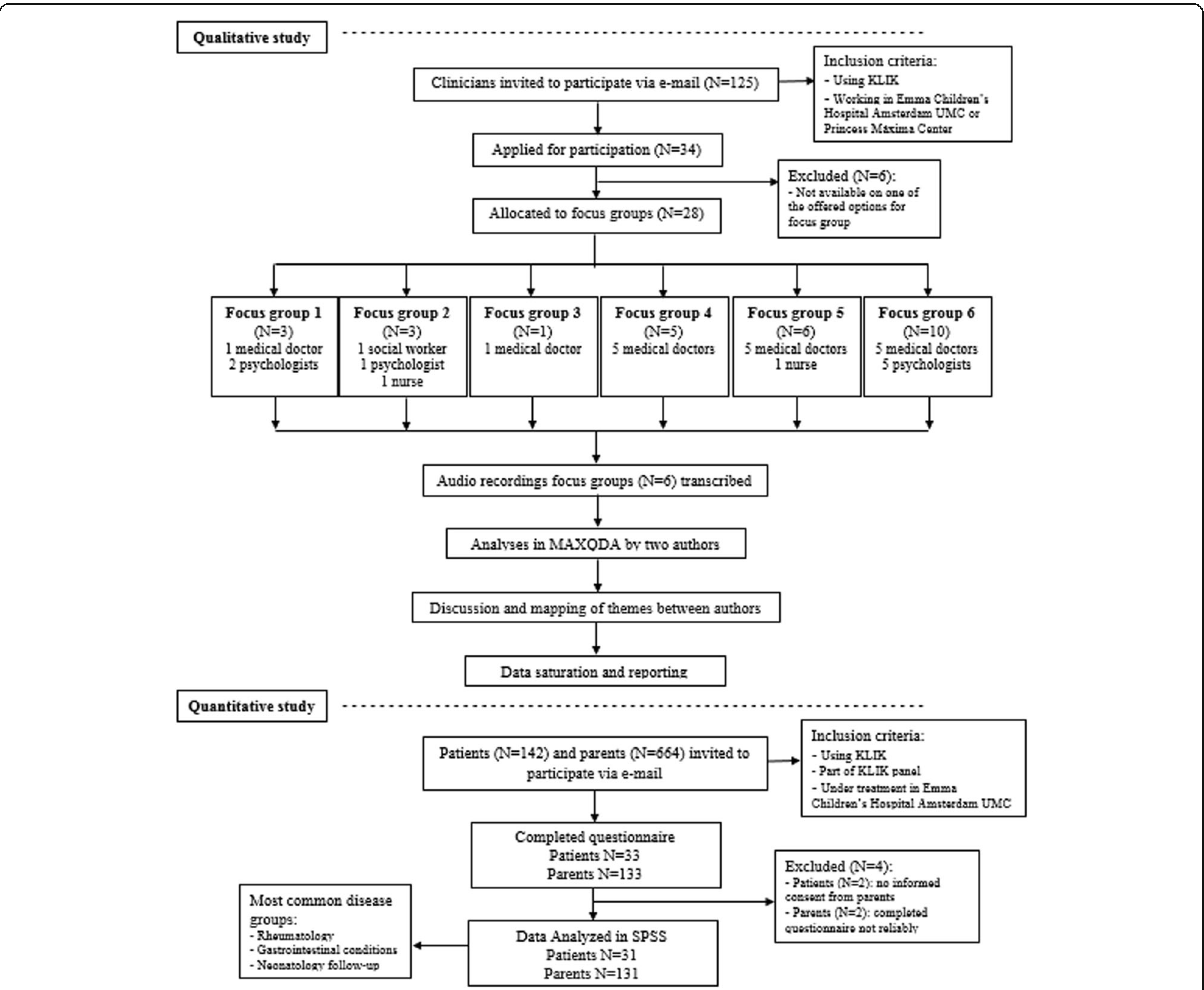
Fig. 2 Study and participant flow chart of the qualitative (focus groups) and quantitative (questionnaire)